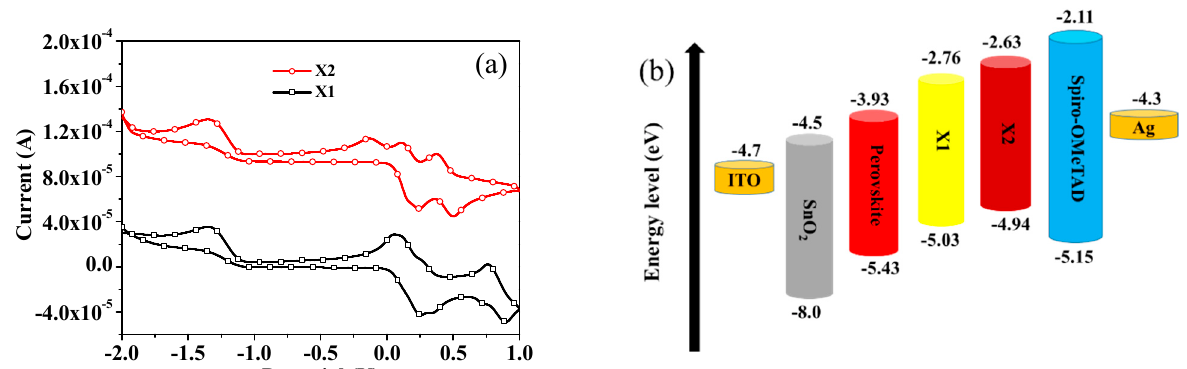
Figure 2. ( a ) Cyclic-voltammogram curves of compounds X1 , X2 , spiro-OMeTAD in DCM solution; ( b ) The energy-level diagram of X1 , X2 , spiro-OMeTAD, and CH 3 NH 3 PbI 3 .